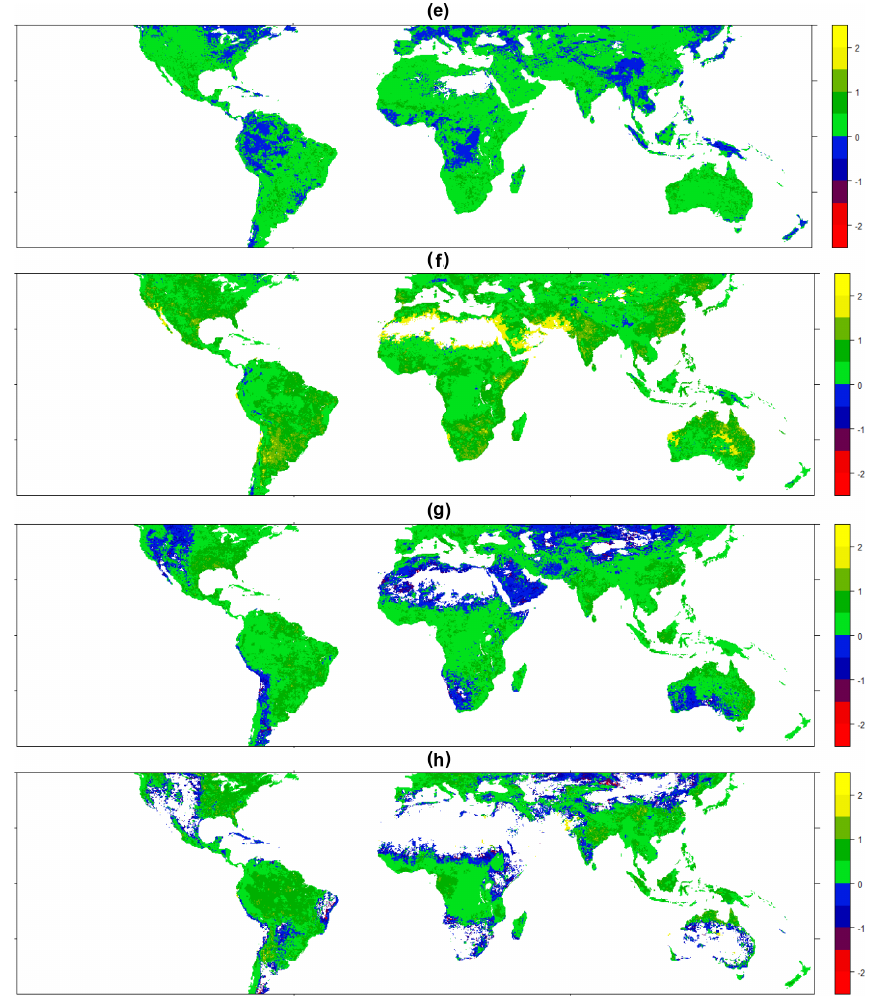
Figure 7. Values of log 10 (ε X,j ) , where ε X,j is the total uncertainty in variable X (Eq. 3), where X is evapotranspiration (a, c, e, f) or runoff (b, d, g, h) and where j refers to either high extremes (a, b, e, g) or low extremes (c, d, f, h) . Points on the scatter plots are coloured according to latitudinal zones (Fig. 1). Because of the density of overlapping points, only the envelope of points for each latitudinal zone is shown and the points with the highest uncertainty (uncertainty DIU ≥ ( 2 / 3 ) · (global maximum of DIU)). Linear regression lines for each latitudinal zone indicate the trend as precipitation increases within each zone (all regressions were significant at the 1% level), although, n.b., we do not contend in any way that the distribution of points shown is linear: these lines simply indicate a trend that is not clear to the eye from the envelopes displayed (which do not show the complete point cloud). Maps (e–h) show the corresponding spatial distributions of log 10 (ε X,j ) values for each variable, with the colour scales corresponding to the vertical axis on scatter plot (a)